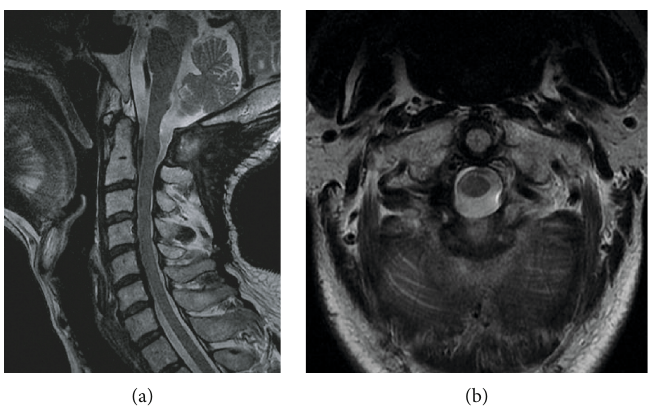
Figure 5: (a, b) T2-weighted sagittal and axial MRI at one year after surgery showed no obvious recurrence.